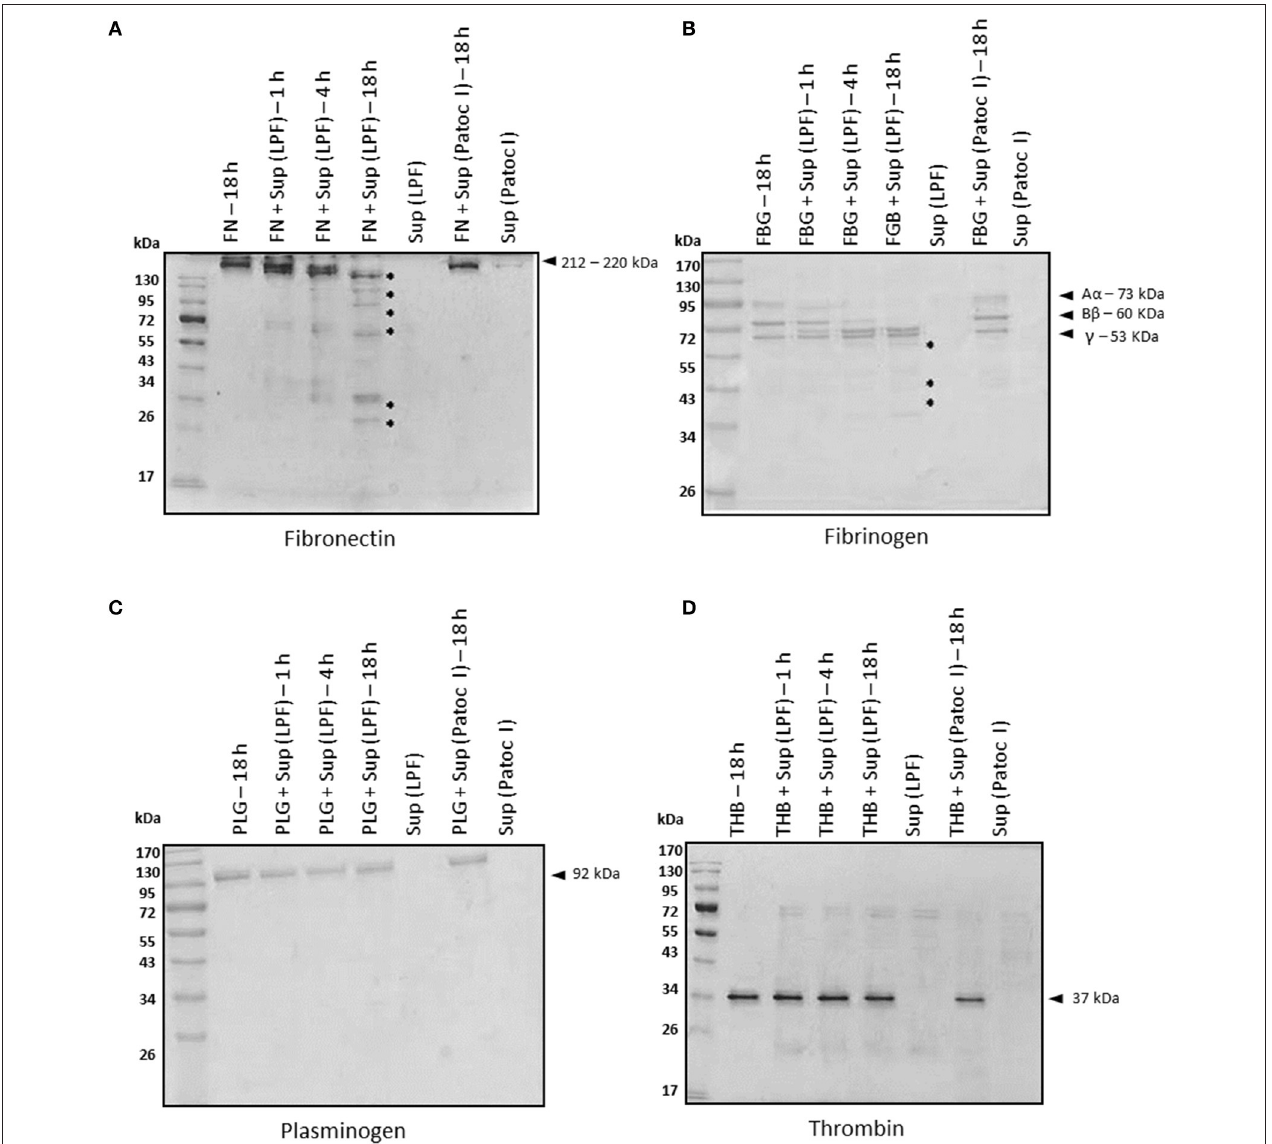
FIGURE 2 | Degradation of plasma proteins by Leptospira interrogans secreted proteases . (A) Plasma fibronectin (5 µ g), (B) fibrinogen (15 µ g), (C) plasminogen (5 µ g), and (D) thrombin (1 µ g) were incubated with supernatants of pathogenic Leptospira interrogans serovar Kennewicki strain Fromm or saprophytic Leptospira biflexa serovar Patoc strain Patoc I (0.5 µ g of total secreted proteins) at 37 ◦ C for the indicated time points. Cleavage products were evaluated by SDS- polyacrylamide gel under reducing conditions. Gels were silver stained. FN, plasma fibronectin; FBG, fibrinogen; PLG, plasminogen; THB, thrombin; Sup (LPF), supernatant of Leptospira interrogans serovar Kennewicki strain Fromm; Sup (Patoc), supernatant of Leptospira biflexa serovar Patoc strain Patoc